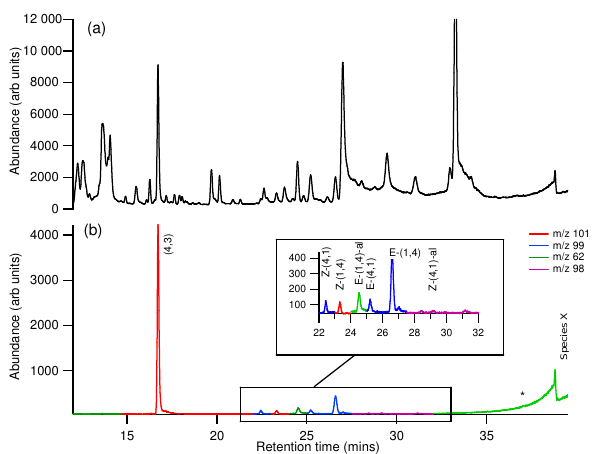
Figure 3. Results of a bag photochemistry experiment analysed on a 30m, 0.32mm ID Rtx-200 column using NI mass spectrome- try. (a) Total Ion Chromatogram. (b) Composite extracted-ion chro- matogram of the data in (a) . The small peak marked ( ∗ ) has the same retention time and ions as the small impurity in the synthe- sised species X.